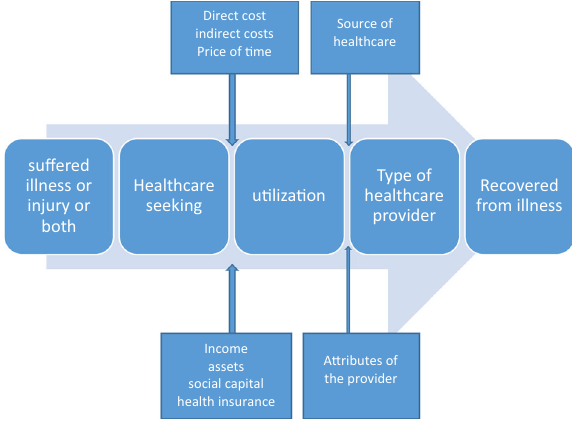
Fig. 1 Conceptualization of demand for healthcare. The concept of demand for healthcare showing the journey from when an individual is experiencing ill-health to when he/she is fully recovered. In between these two extreme ends, the individual has certain decisions to make. First, the decision to seek healthcare or not. Second, if the individual decides to seek healthcare, they must pay the direct cost and indirect cost associated with the healthcare seeking behavior. The direct costs includes the cost of treatment, often measured by out-of-pocket payment (amount paid for folder, diagnosis, drugs, and treatment, hospital stay, any other payment) and the indirect costs includes travel time, travel cost, and waiting time. The presence of health insurance helps to reduce the cost of